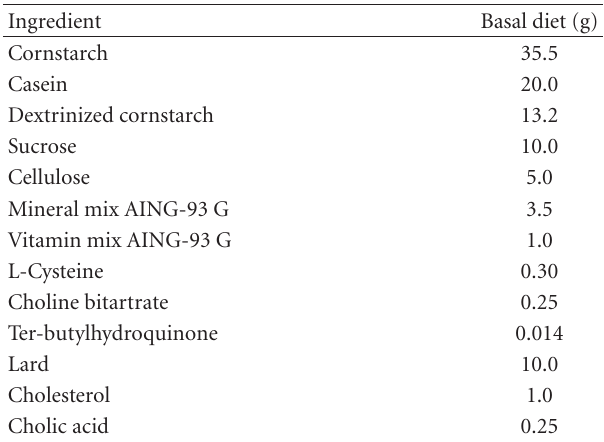
Table 1: Composition of basal and experimental diets. Experimen- tal diets are Basal diet plus Hibiscus sabdari ff a ethanol calyx